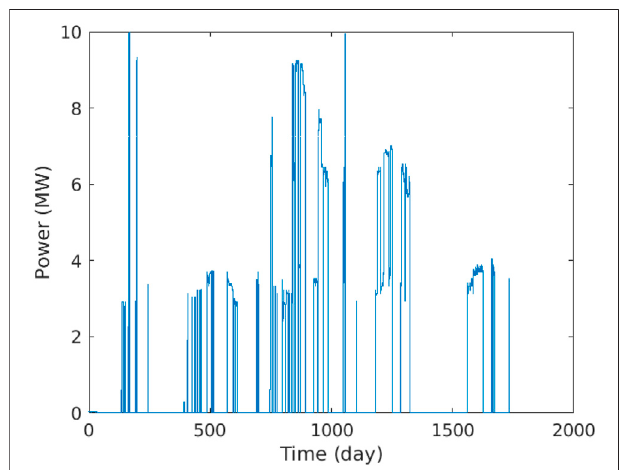
FIGURE 2 | HTR-10 detailed power history.